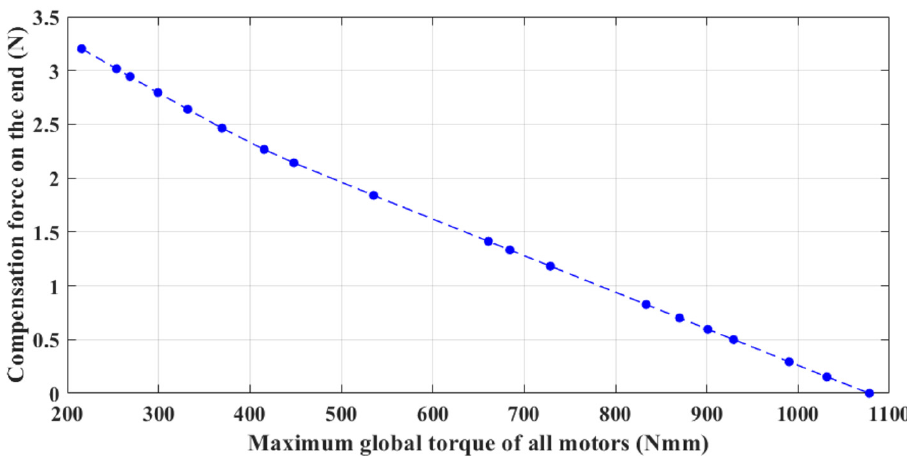
Figure 5. Optimization results of passive gravity compensation.